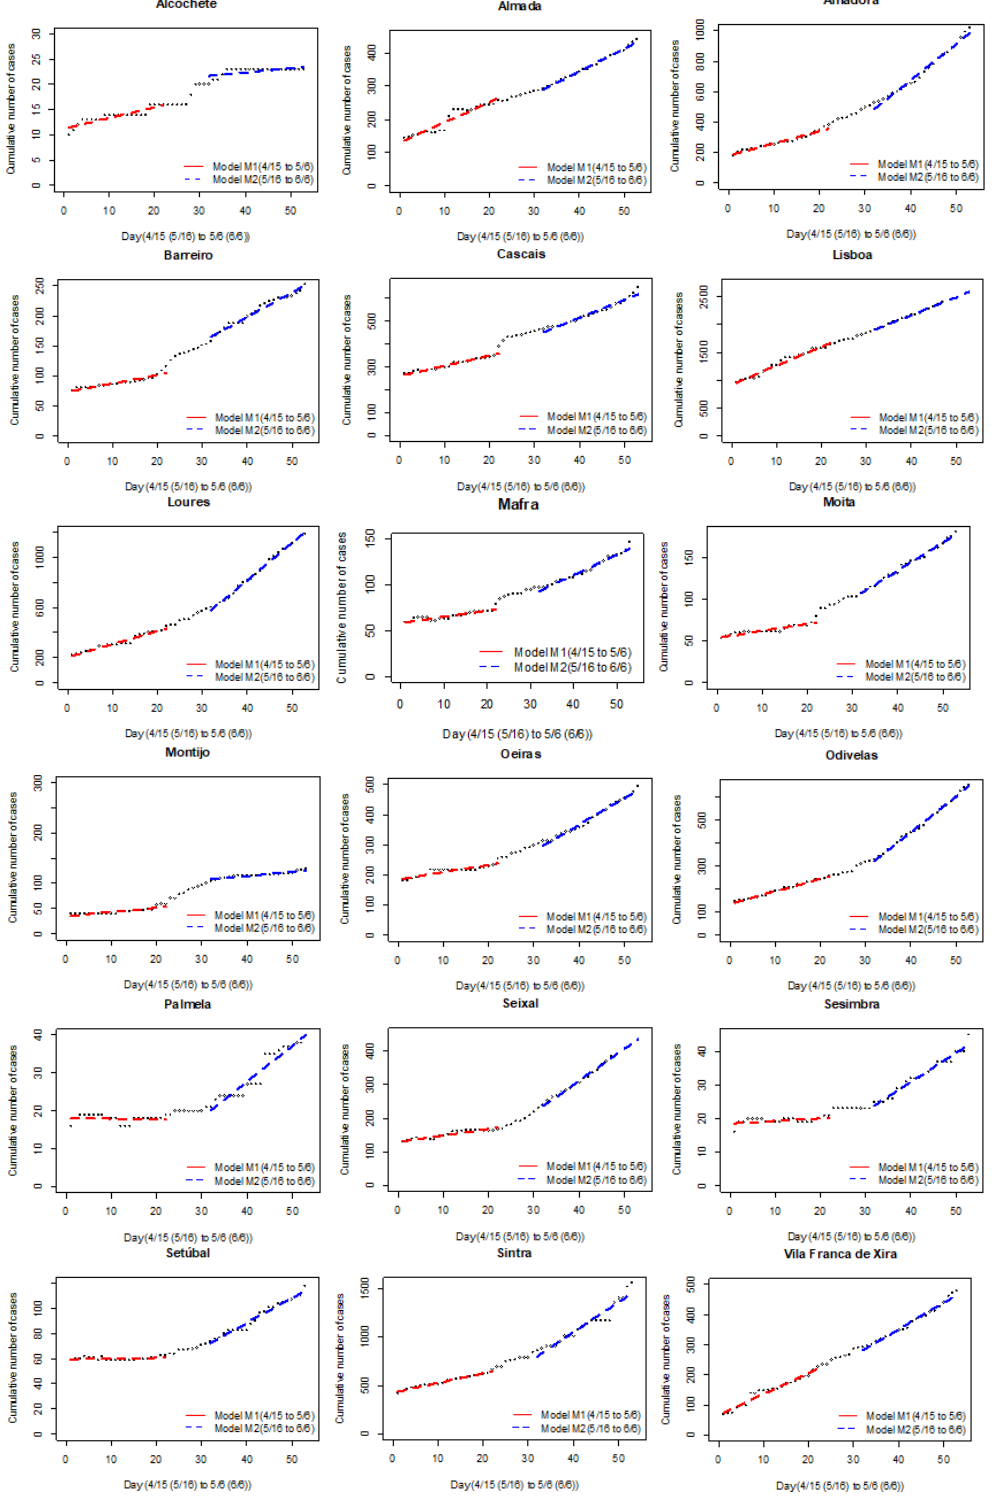
Figure A1. Linear models adjusted to the S 1 and S 3